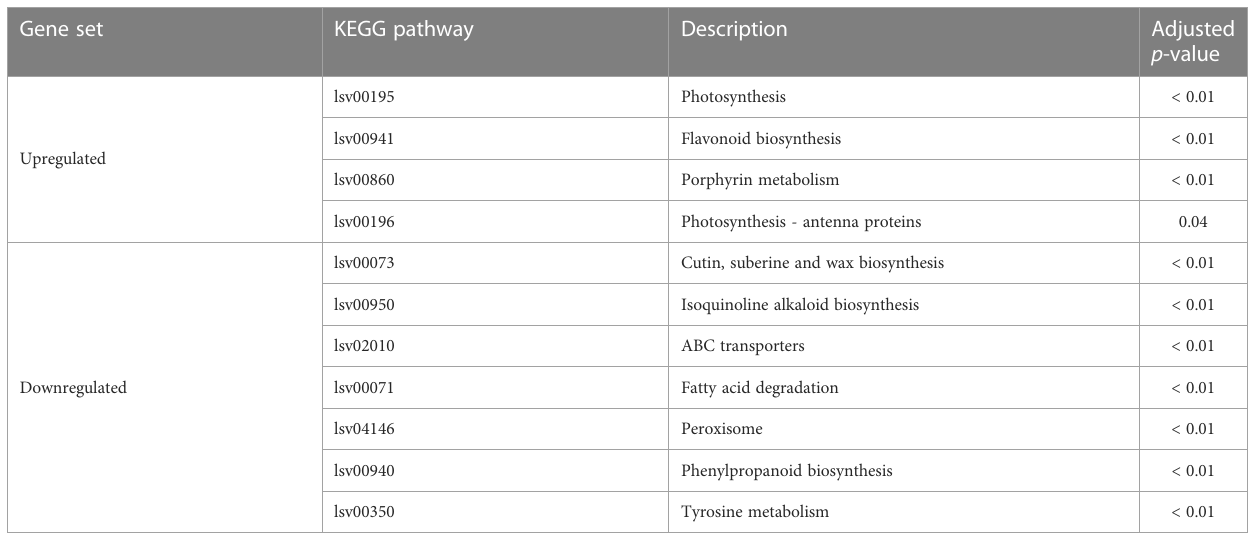
TABLE 2 Enriched KEGG pathways for the up- and downregulated gene sets observed for the lettuce plants in chitin-amended potting soil (PS+CH) in comparison to non-treated control plants (PS). Gene set